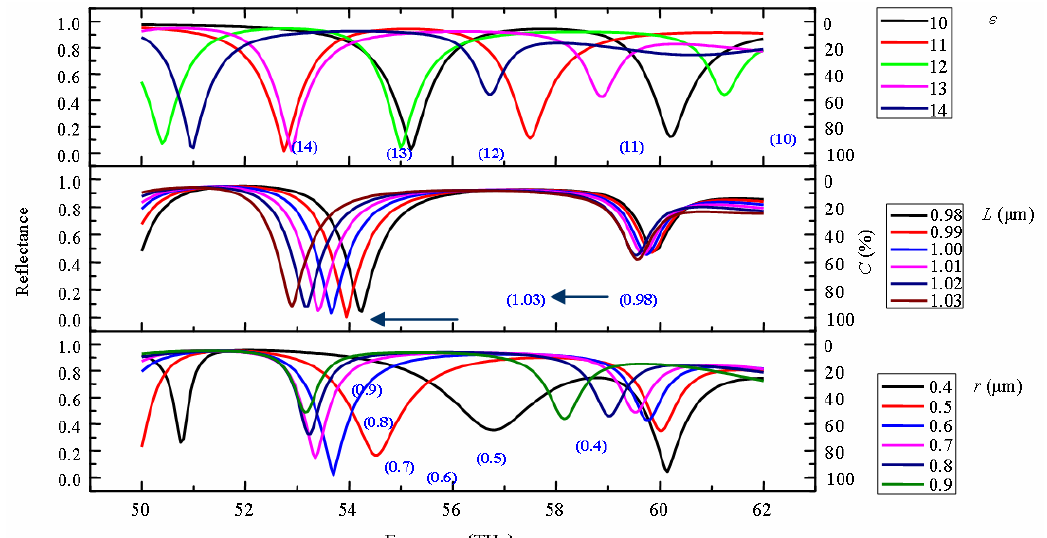
Fig. 2 Reflection spectra of the cylindrical microcavity in the MDM structure at the normal incident TM plane wave: (a) reflectivity spectra with the change in the dielectric constant  , L =1  m, h =0.45  m, H =0.45  m, and P =3  m, (b) reflection spectra with the change in L , r =0.6  m, H =0.45  m, and P =3  m, and (c) reflectivity spectra with the change in r , L =1  m, h =0.45  m, H =0.45  m, and P =3 